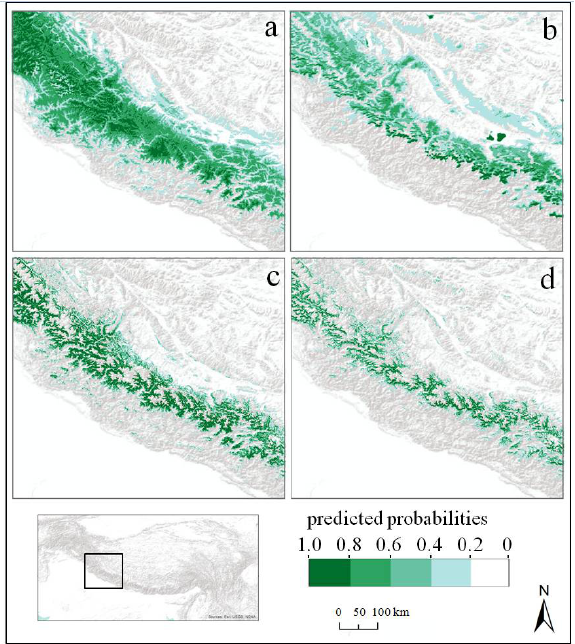
Figure 5. Detailed excerpt of continuous predicted occurrence probability using four different predictor variable sets: ( a ) Chelsa climate data (C LIMATE ); ( b ) Land Surface Temperature (L ST ); ( c ) Chelsa climate data, Topography and Land Cover Dynamics data (C LIMATE + T OPO + P HENO ); ( d ) Land Surface Temperature, Topography and Land Cover Dynamics data (L ST + T OPO + P HENO ). For detailed continuous prediction of all models, see Supplementary Material Figure S3.